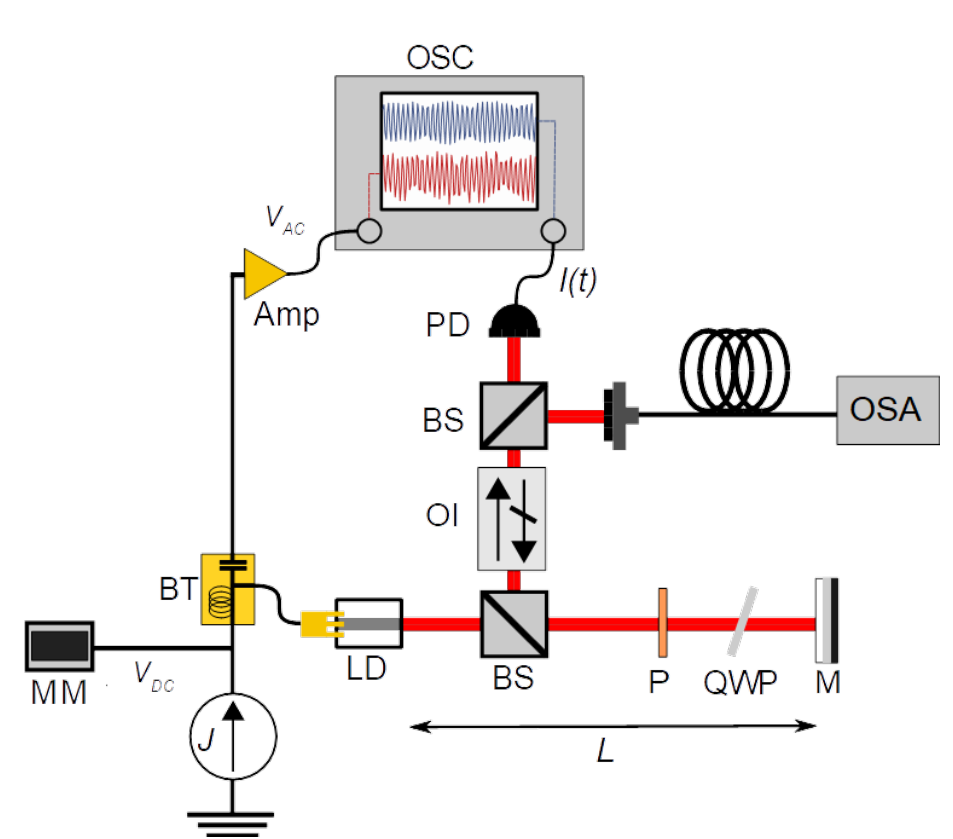
Figure 1. Experimental Setup. LD: laser diode, M: mirror, QWP: quarter-wave plate, P: polarizer; BS: beam splitter, OI: optical isolator, PD: photodetector, BT: bias tee, Amp: amplifier. MM: multimeter, OSA: high-resolution optical spectrum analyzer, OSC: real-time oscilloscope. The model numbers are given in Refs. [17,18]. Not represented: the heterodyne scheme used to measure the optical phase (please refer to Refs. [14,16]).